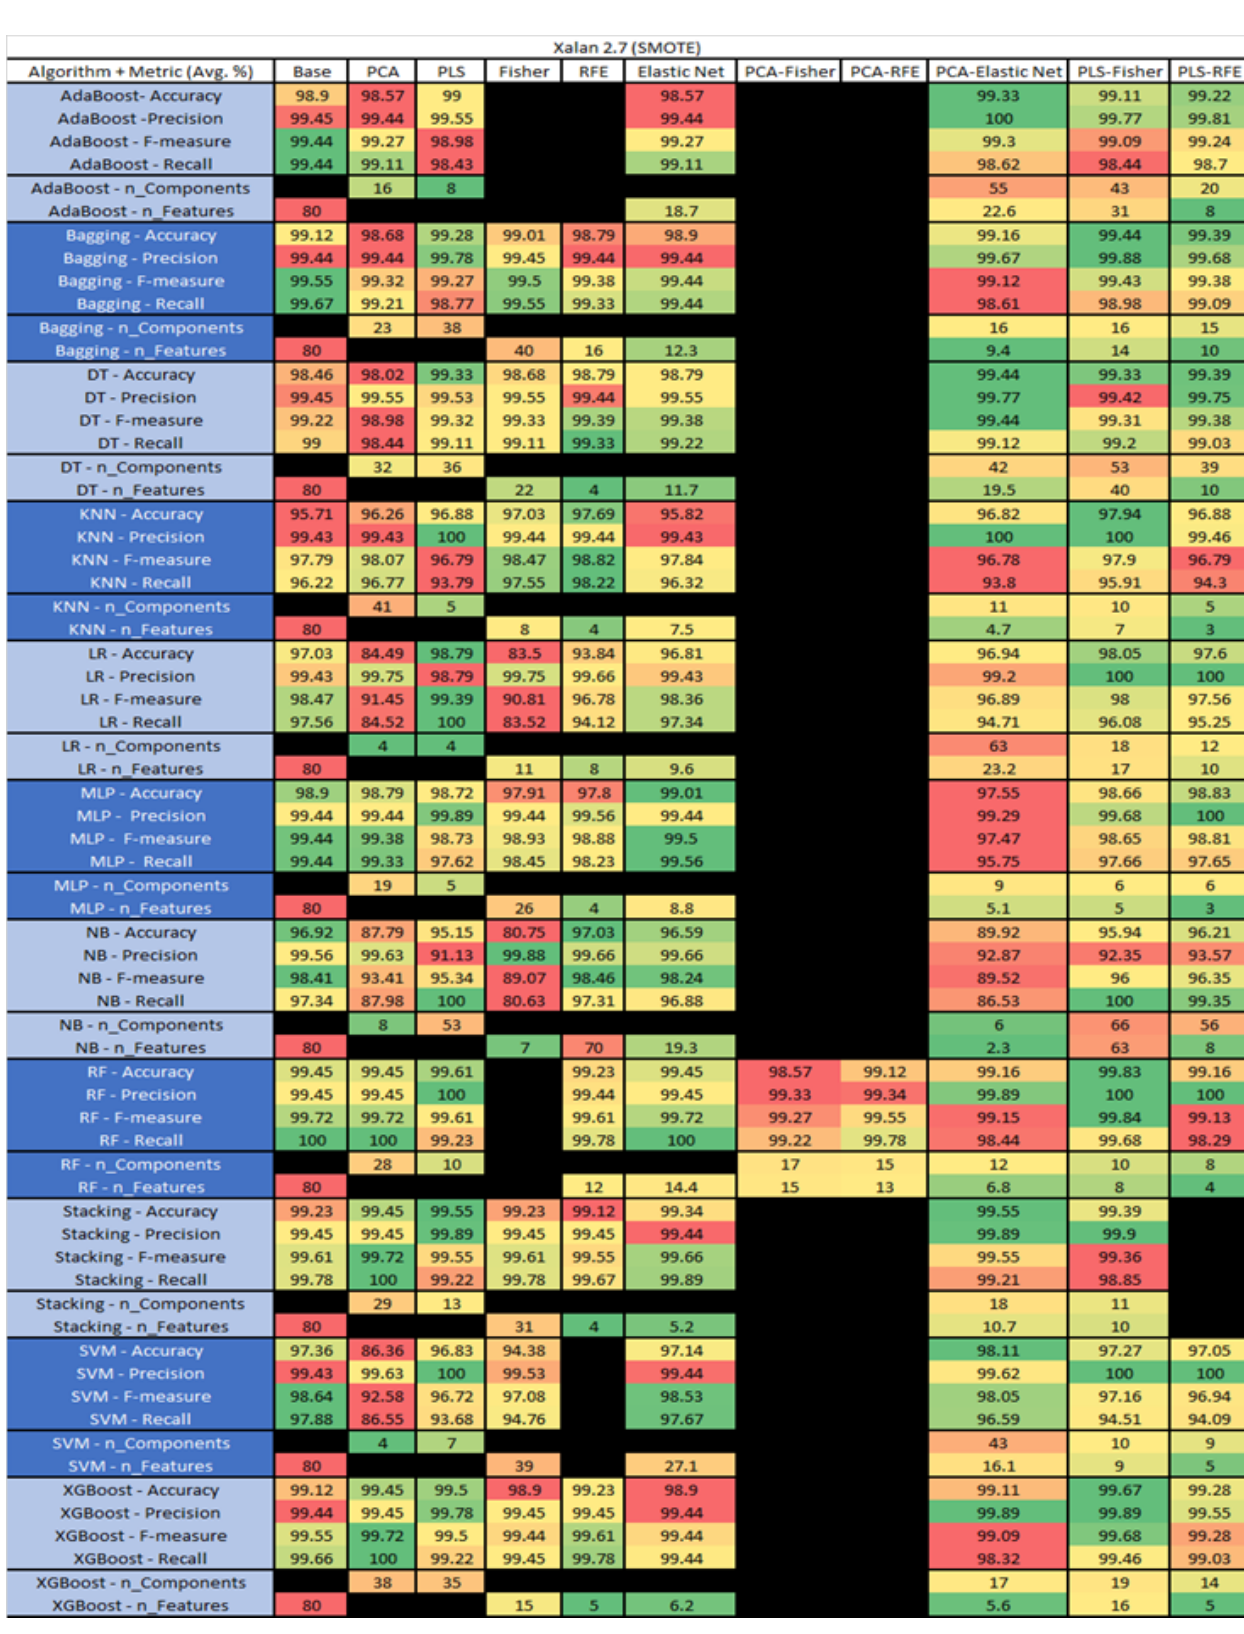
Figure 57. Xalan 2.7 SMOTE PROMISE Results Data